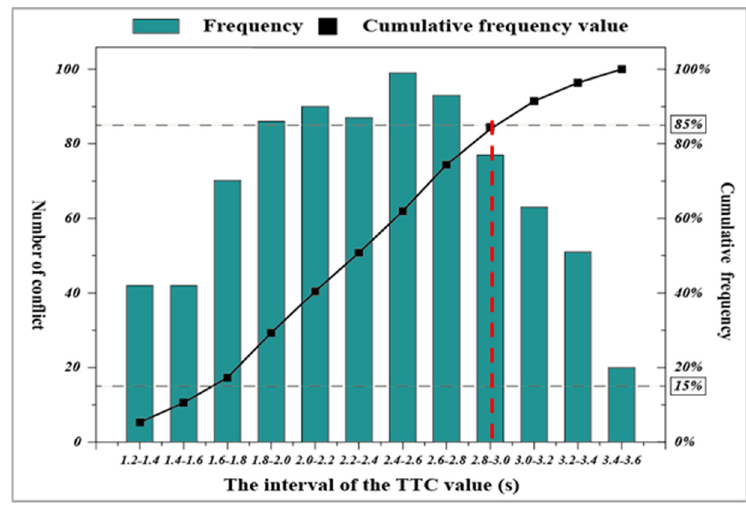
Figure 9. Cumulative frequency distribution of general conflicts.